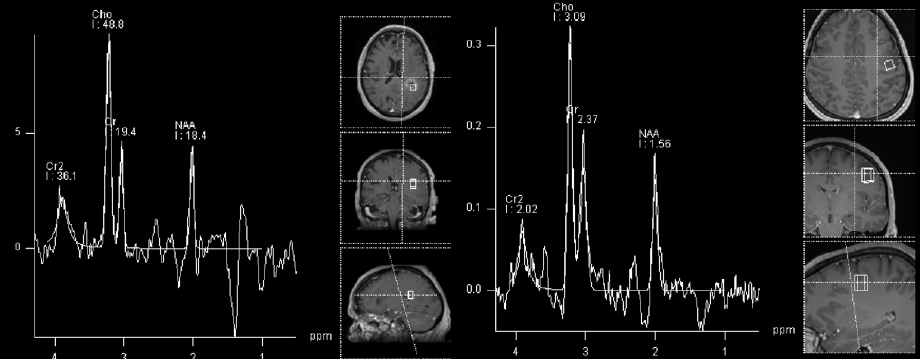
Figure 3. Similar 1H-MRS spectra can be appreciated in an adult patient with glioblastoma ( left , black arrow) and in a patient with astrocytoma WHO grade 2 ( right , white arrowhead) with increased NAA and decreased Cr and